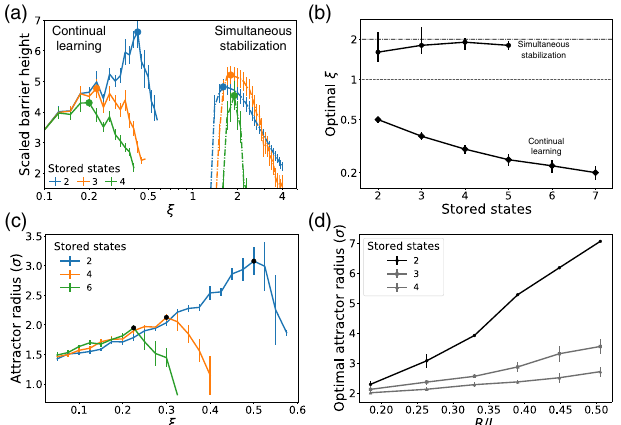
FIG. 3. Optimal nonlinearity for continually learned states. (a),(b) Barrier heights around learned states are highest at a specific nonlinearity 0 < ξ (cid:2) < 1 . Further, learning more states requires stronger nonlinearity ξ (cid:2) (compared to simultaneously stabilized sates that are most stable with for ξ (cid:2) ≈ 2 , or linear springs). (c) We find similar results by quantifying learning Eq. (1), lead to larger attractor basins (see Appendix D for details). L is the system length, σ ¼ 5 × 10 − 3 L . Results averaged over 45 simulations of N ¼ 100 particle